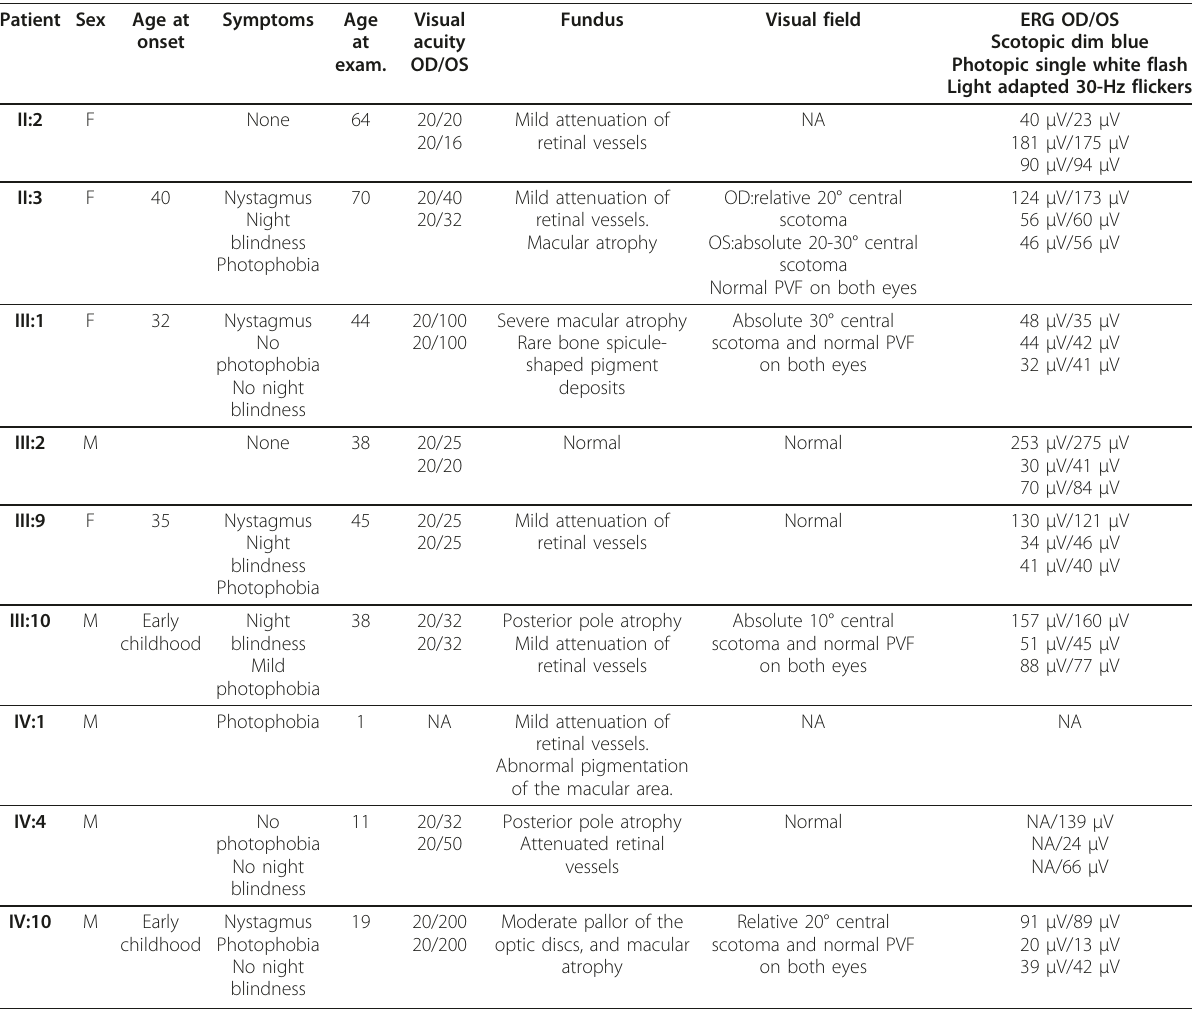
Table 1 Clinical features of patients with cone-rod dystrophy Patient Sex Age at Symptoms Age Visual onset at acuity exam. OD/OS